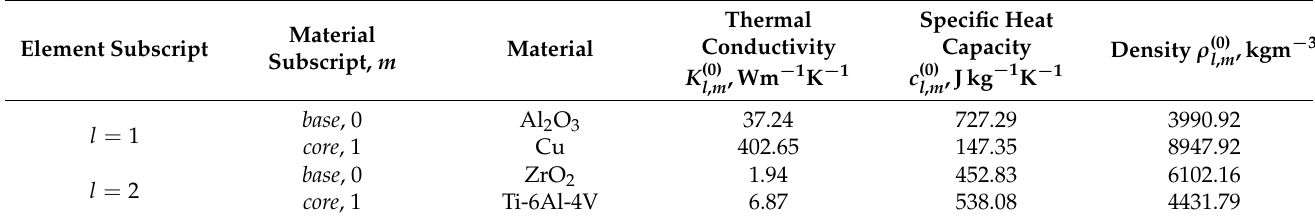
Table 1. Thermo-physical properties of FGM components